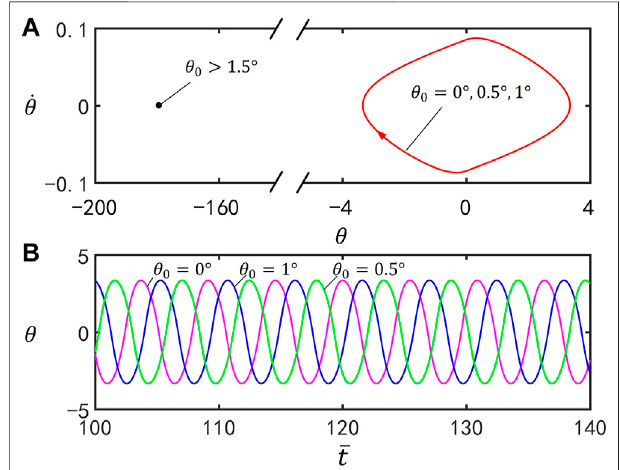
FIGURE 5 | Effect of the initial position θ 0 on self-stabilized oscillation of the inverted pendulum for (cid:2) I (cid:2) 0 . 25, C 0 (cid:2) 0 . 4, (cid:2) g (cid:2) 9 . 8, (cid:2) ζ (cid:2) 14 . 7, θ (cid:2) 70 ° , and _ θ (cid:2) 0. (A) Limit cycles for θ (cid:2) 0 ° , 0 . 5 ° , and 1 ° . (B) 1 0 0 Time series curves for θ 0 (cid:2) 0 ° , 0 . 5 ° , and 1 ° . It can be seen that the initial position θ 0 has no in fl uence on the amplitude and period of self- stabilized